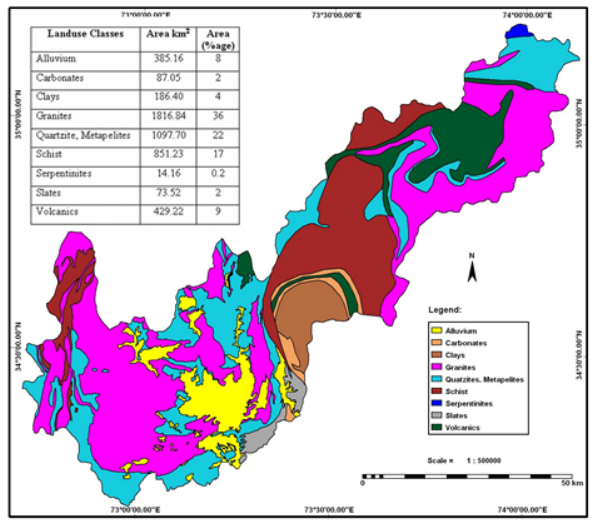
Figure 2. Lithological map of Mansehra